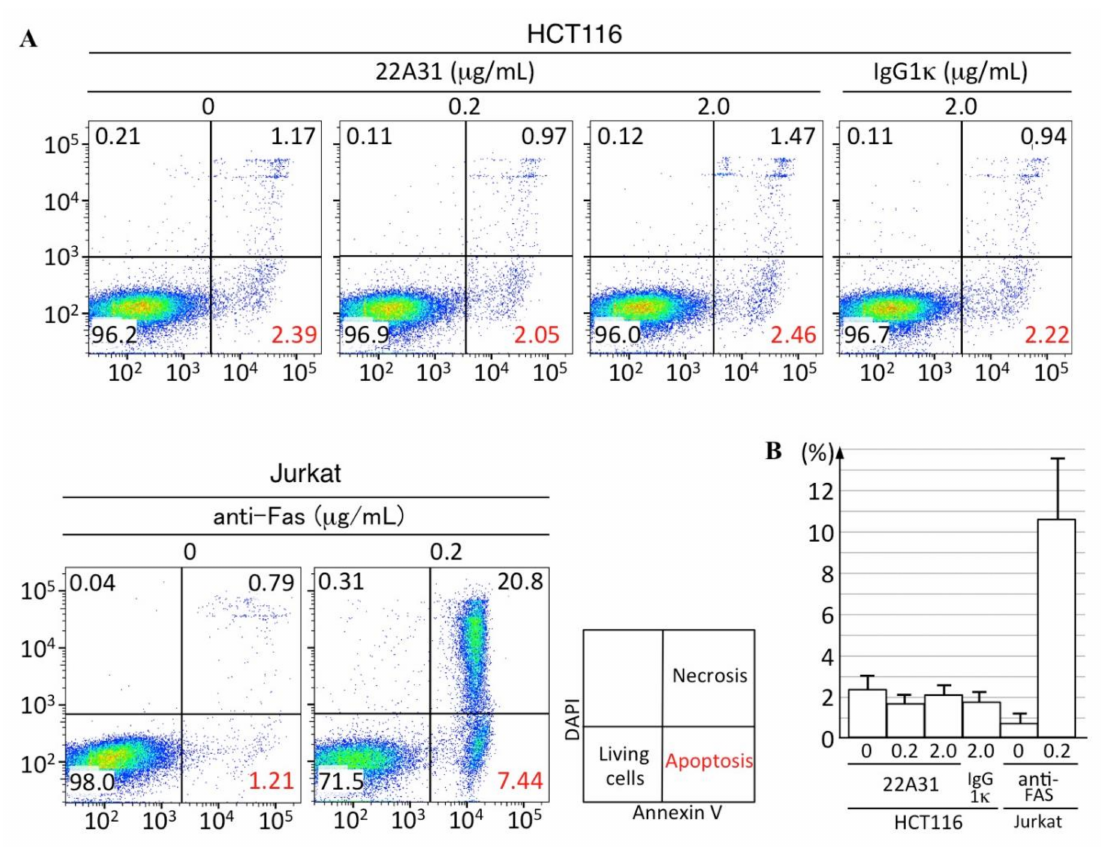
Figure 5. Apoptotic cells in HCT116 detected by Annexin V positivity after treatment with 22A31. ( A ) Representative dot-plots. The percentage of apoptotic cells is shown in red numbers in a right lower quadrant of each dot-plot. ( B ) Quantified data of apoptotic cells (mean ± SD) in three experi- ments. HCT116 cells were incubated with 0 or 0.2 or 2.0 µ g/mL 22A31 at 37 ◦ C for 24 h and then were subjected to flow cytometric analysis. As a negative control, HCT116 cells were treated with IgG1 κ 2.0 µ g/mL. As a positive control, Jurkat cells were treated with anti-FAS 0 or 0.2 µ